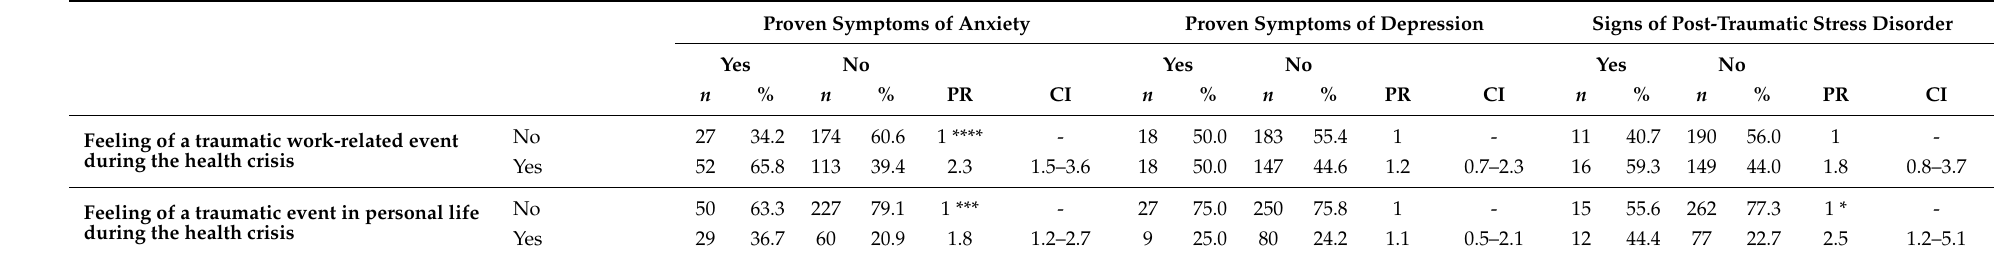
Proven Symptoms of Anxiety Proven Symptoms of Depression